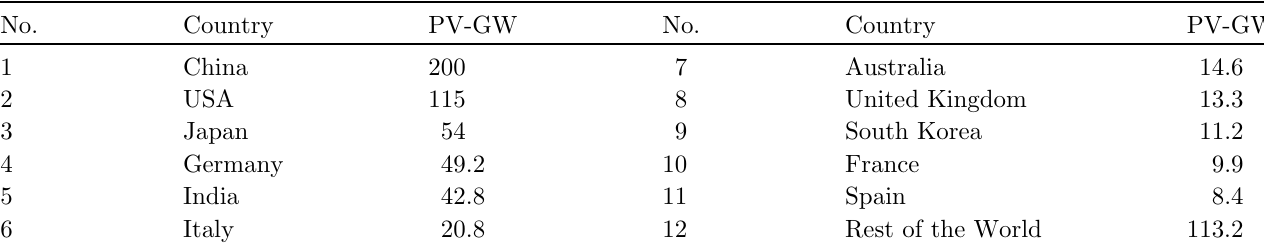
Table 6. Below shows selected countries with Photovoltaic capacity at the end of 2019.